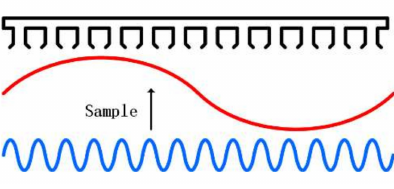
Figure 5. Schematic diagram of electromagnetic force sampling by stator slot.